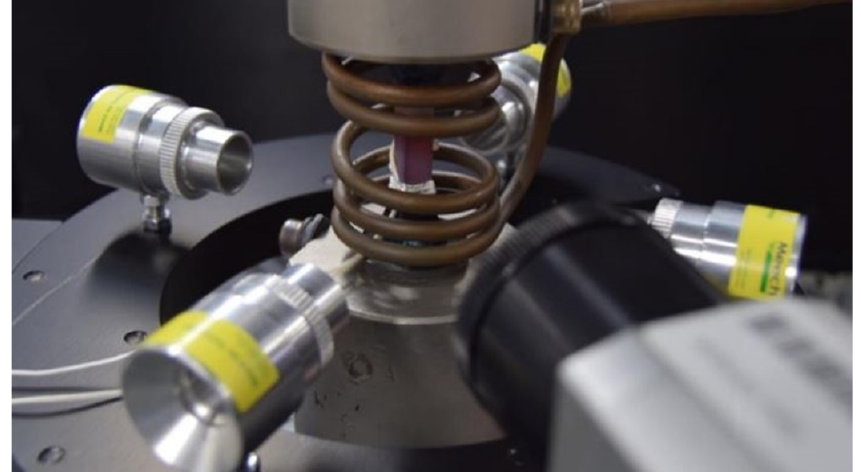
Figure 5. Final setup utilised for TMFCG testing. As shown, a non-uniform multi-turn longitudinal helical field induction coil is adopted for the heating and four air amplifiers, situated on a platform, are used for the cooling. Additionally integrated, is an infra-red camera [15] .